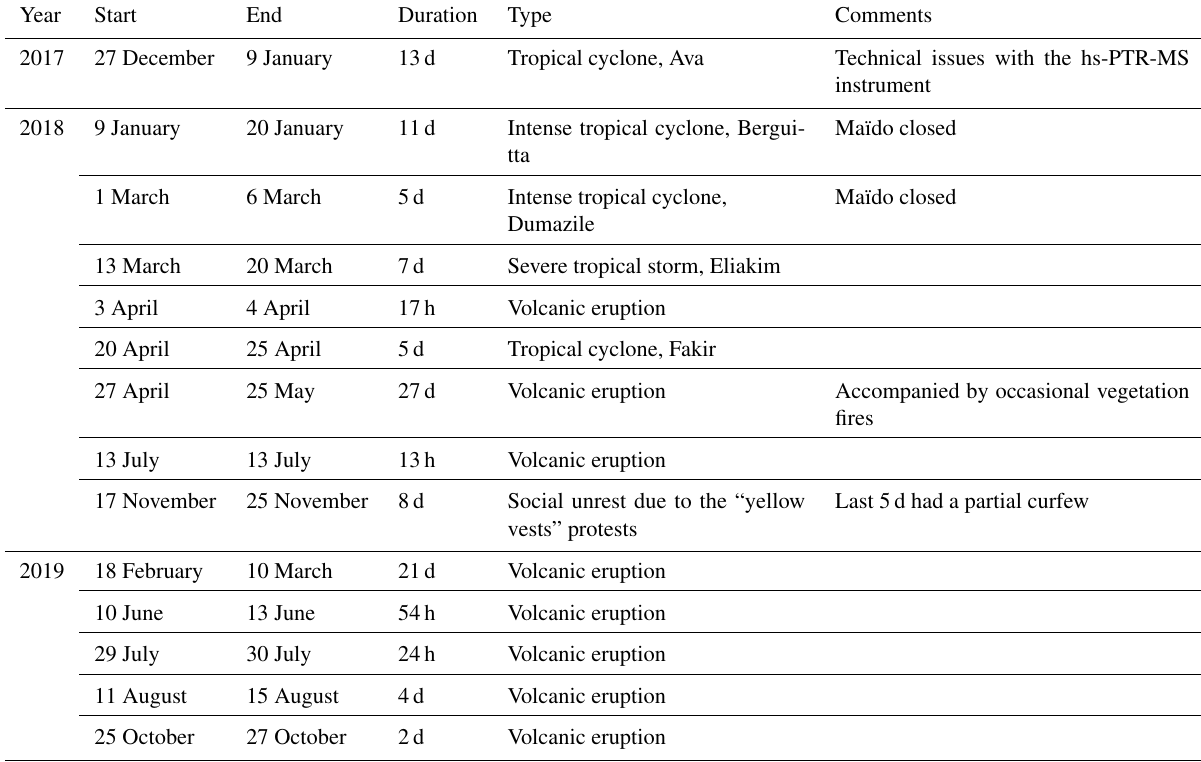
Table 1. Special events with potential impact on VOC concentrations during the 2-year deployment of the hs-PTR-MS. During some of these events the hs-PTR-MR was shut down due to security measures at the Maïdo observatory. Information is from Fournaise Info (2018), Le Monde (2018), and Météo France